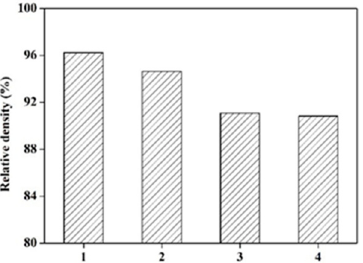
Figure 7. Reflection and its schematic diagram [44].